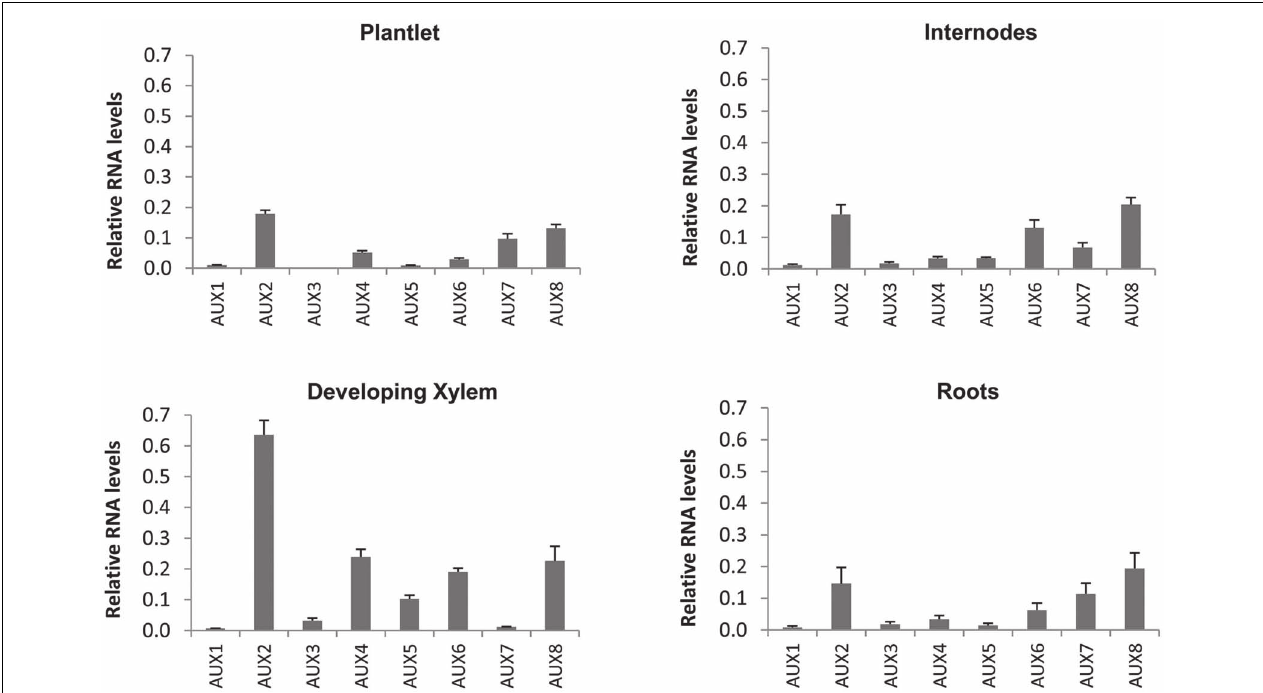
FIGURE 7 | Quantification of AUX/LAX transcripts expression by qRT-PCR. Most AUX/LAX transcripts showed broad expression across plant tissues, including the previously undescribed PtaAUX4–8 . PtaAUX2 and PtaAUX8 were highly expressed in internodes and developing xylem. Error bars represent the SEM.